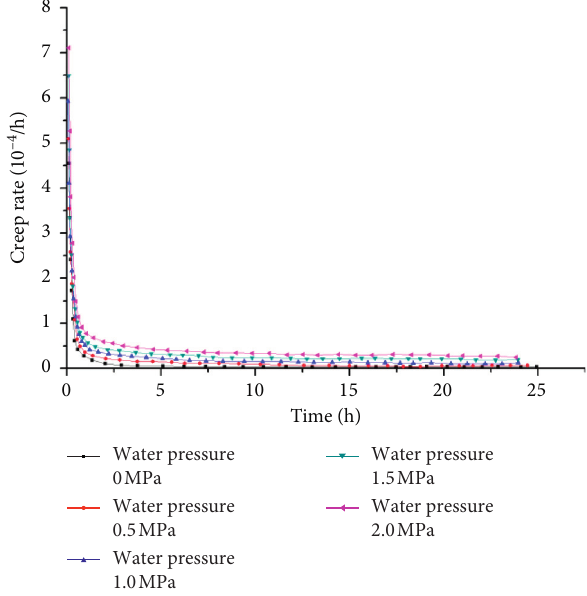
Figure 15: The creep rate under different water pressures at 4.0 MPa axial pressure.